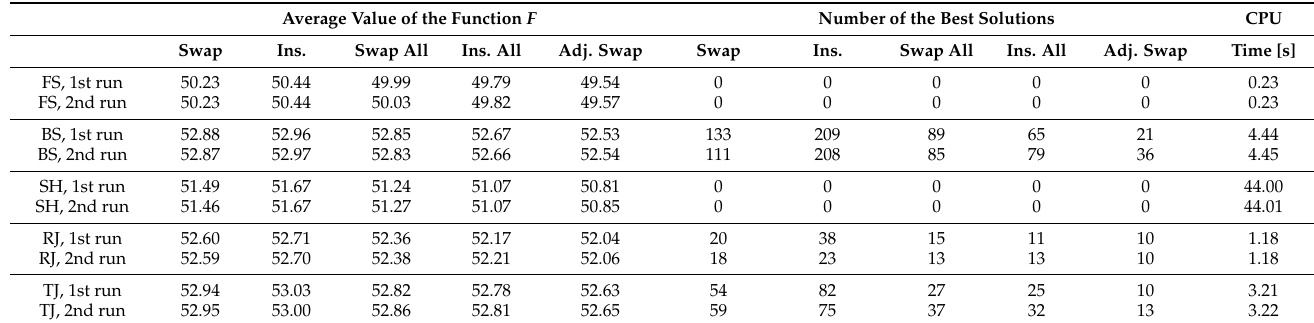
Table 2. Results of the experiments—J90